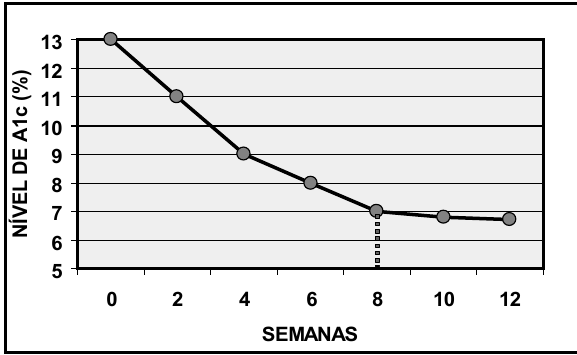
Figura 6 – Taxa de redução de hemoglobina glicada em pacientes bem controlados com tratamento adequado (adaptado de Sacks, D. B. Hemoglobin variants and hemoglobin A1C analysis: problem solved? Clin Chem, v. 49, p. 1245-7,